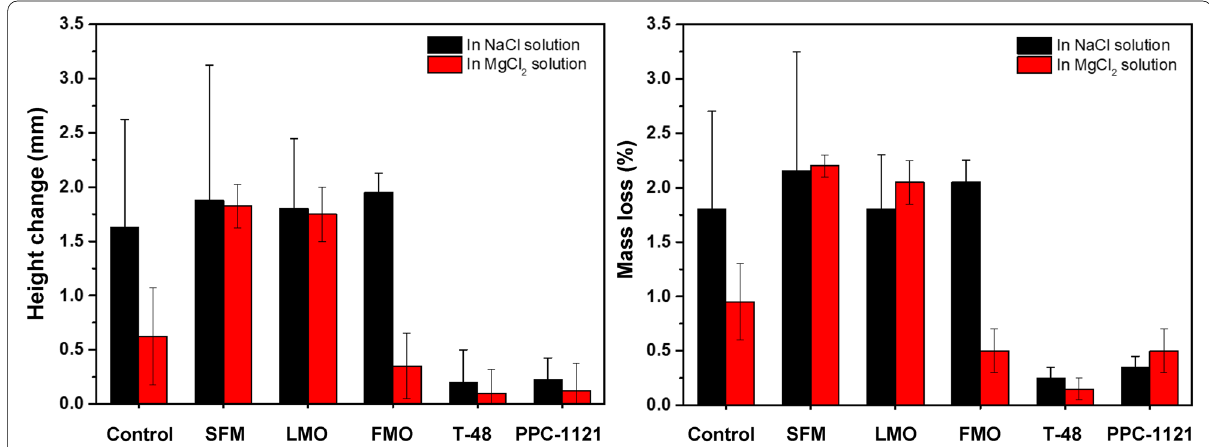
Fig. 4 Abrasion resistance of various overlays after F/T and W/D cycles exposed to deicer solutions: a height change; b mass